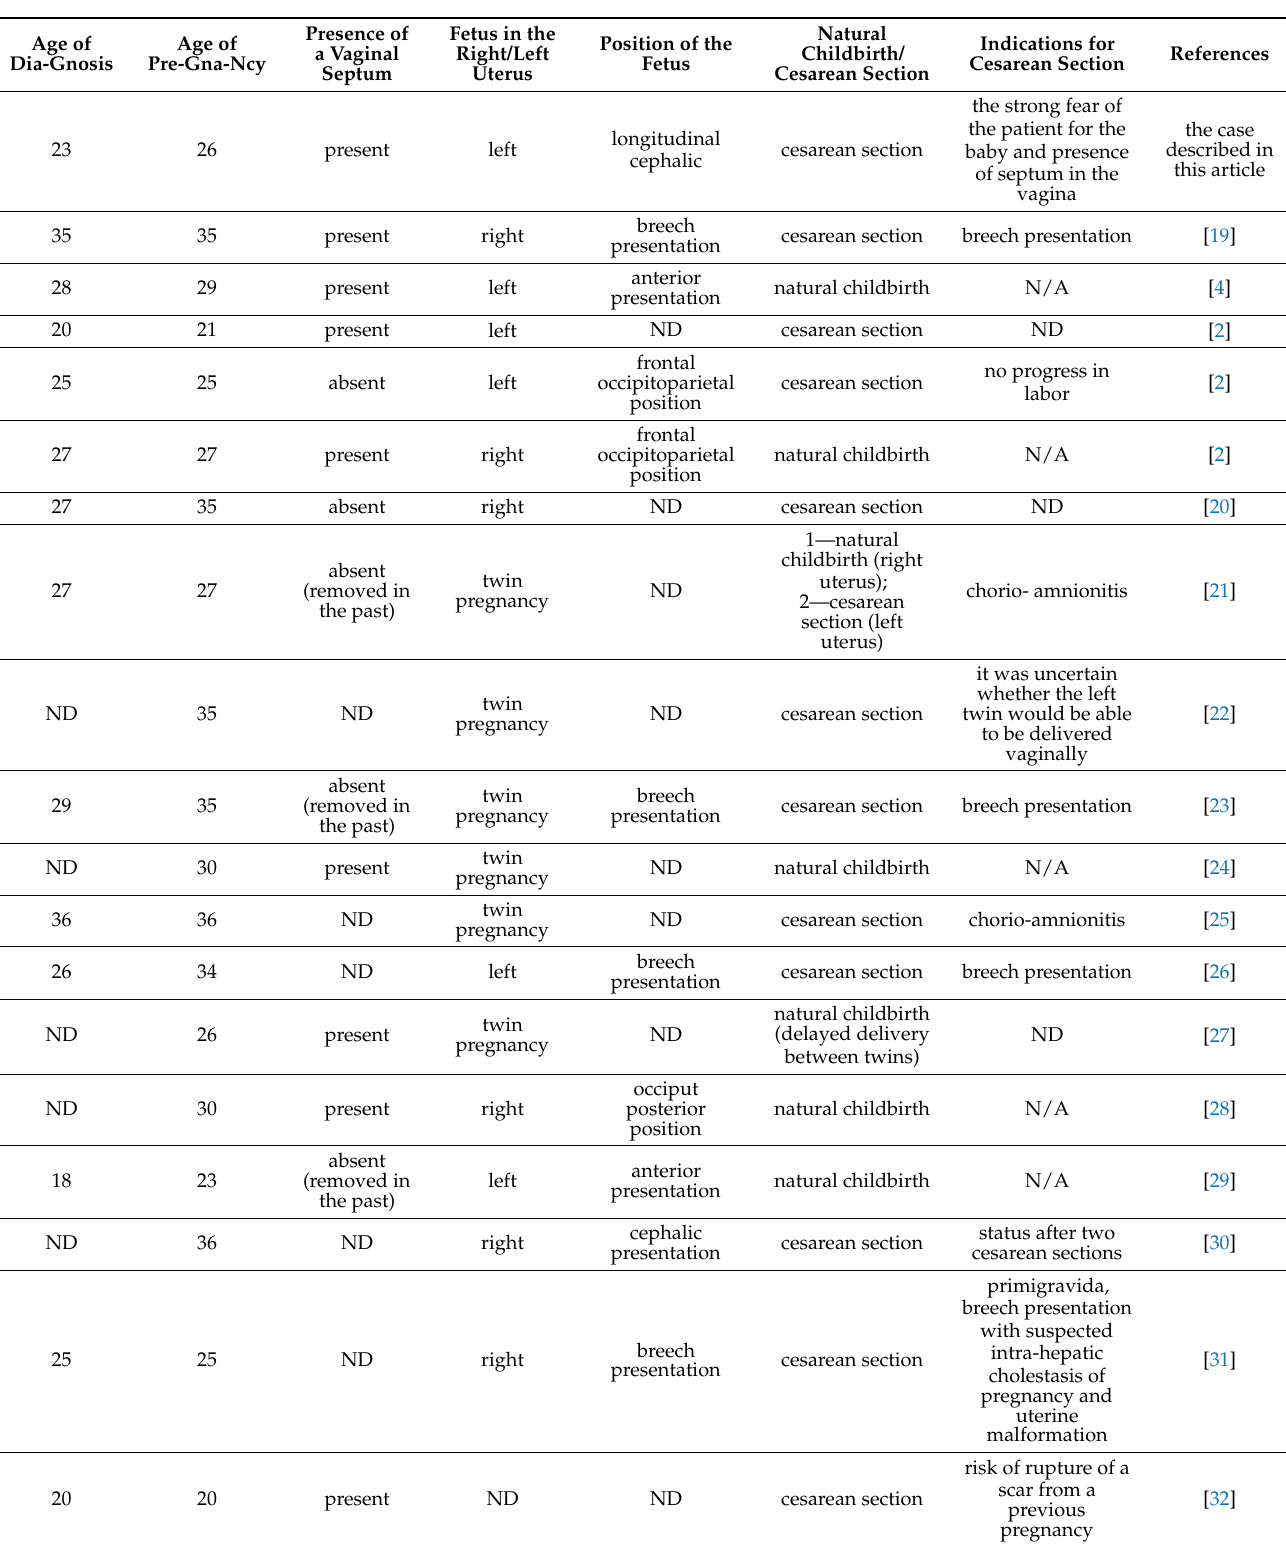
Table 1. Cases of pregnant women with uterus didelphys defect from the literature in last 10 years. N/A—not applicable; ND—no